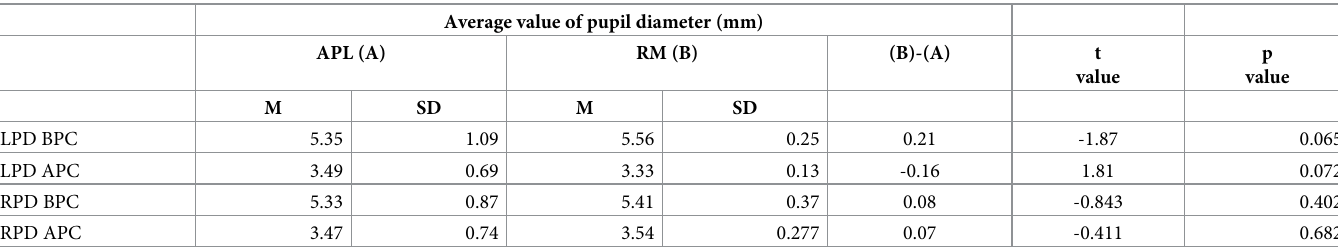
Table 3. Comparison of the APL and the RM (N = 90).